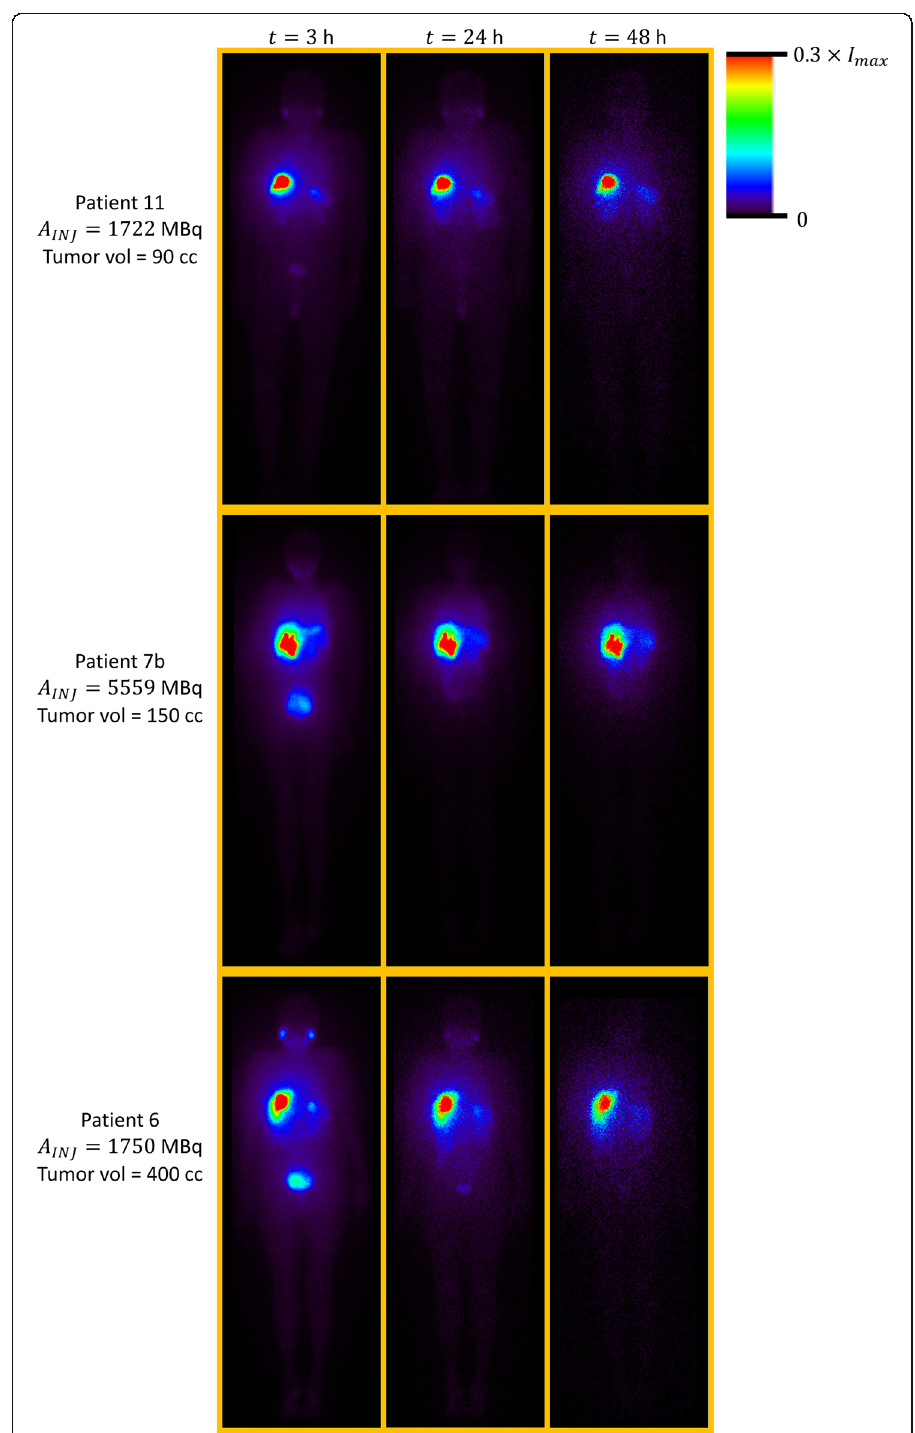
Fig. 1 Whole-body planar images (anterior views) of three patients (no. 11, 7b, and 6) who received an intra-hepatic injection of 188 Re-HDD-Lipiodol. The images were acquired at 3 h, 24 h, and 48 h post-administration of the radiotracer. The quantity I max represents the maximum pixel intensity of each planar